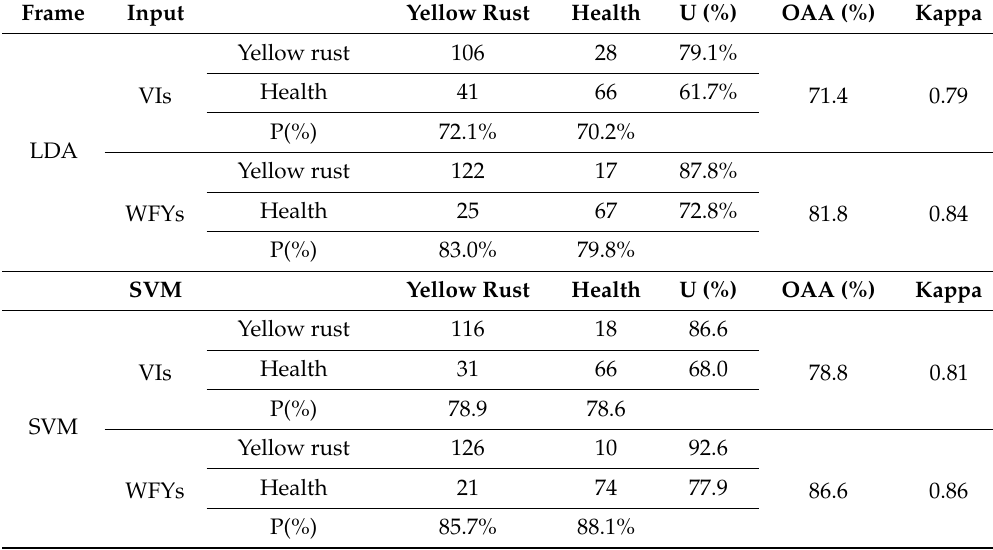
Table 7. Comparison of the overall results of disease discrimination (healthy versus leaves infected with yellow rust) based on the pooled ASD spectroradiometer observations of all dates.